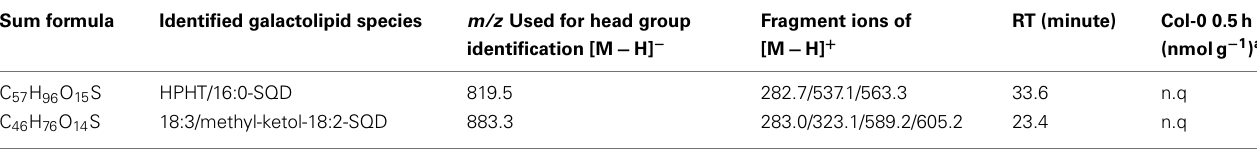
TableA10 | Oxidized SQD species identified in wounded A. thaliana